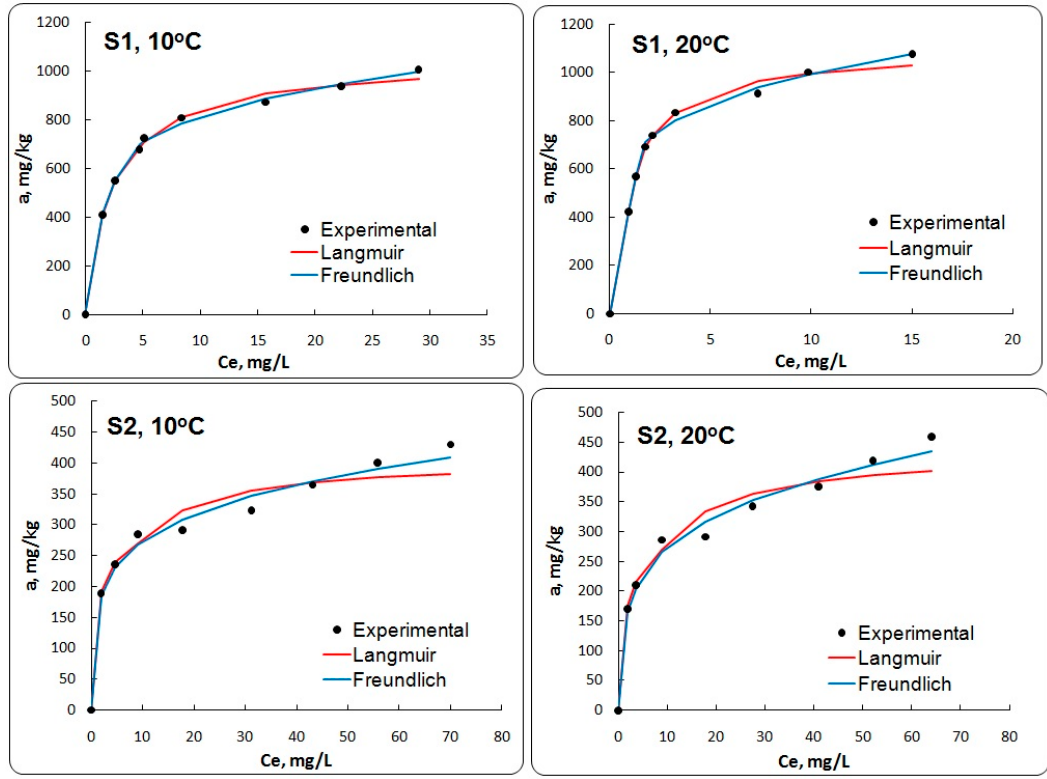
Figure 6. The adsorption curves of Mn 2+ using Mg-Al LDH (sample S1) and Mg-Ni-Al LDH (sample S2), at 10 and 20 °C.